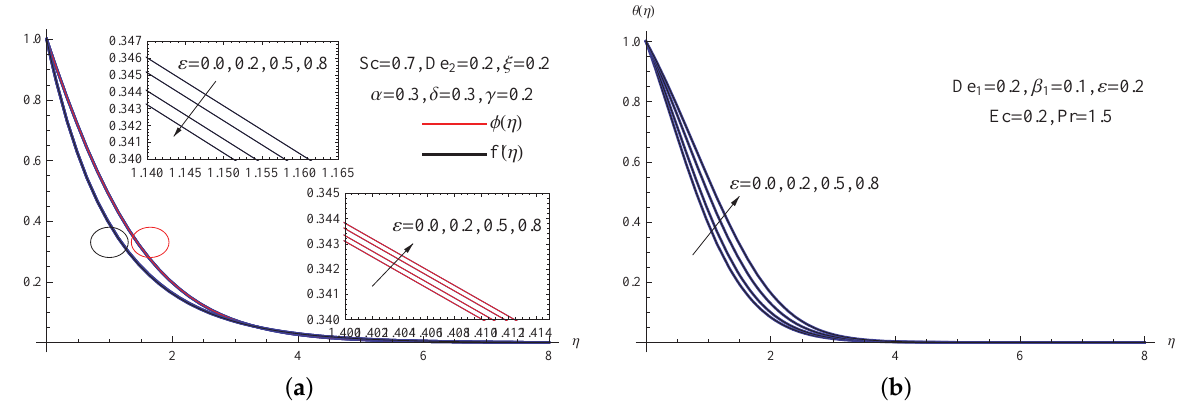
Figure 4. ( a ) f (cid:48) ( η ) for picked γ . ( b ) θ ( η ) and φ ( η ) for picked γ .